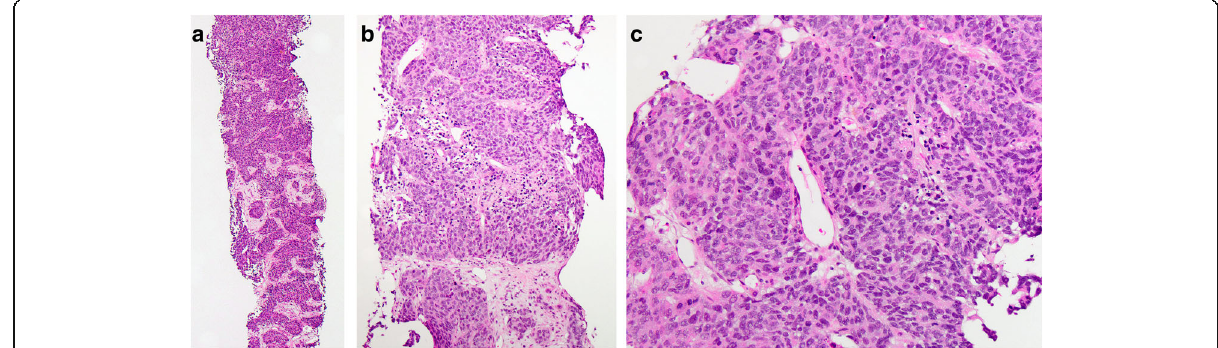
Fig. 1 Liver mass biopsy a infiltration of liver parenchyma by cells arranged in nests and trabeculae [H&E, 40x], b area of central necrosis [H&E, 200x], c cells with high N:C, granular chromatin, inconspicuous nucleoli, and frequent mitoses